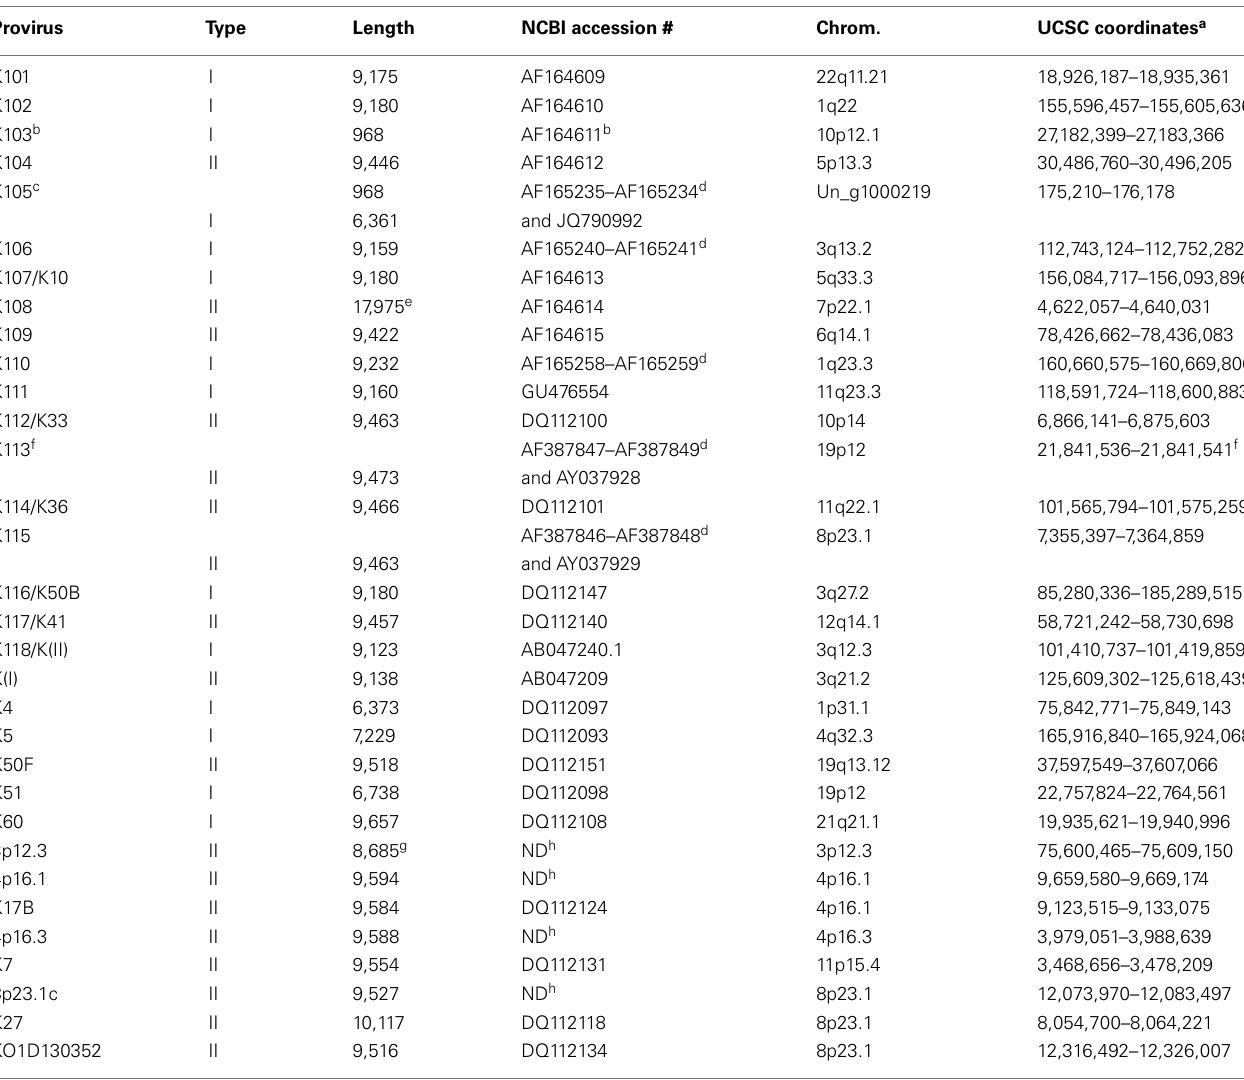
Table 1 | Full-length HERV-K (HML-2) proviruses and their locations in the human genome a